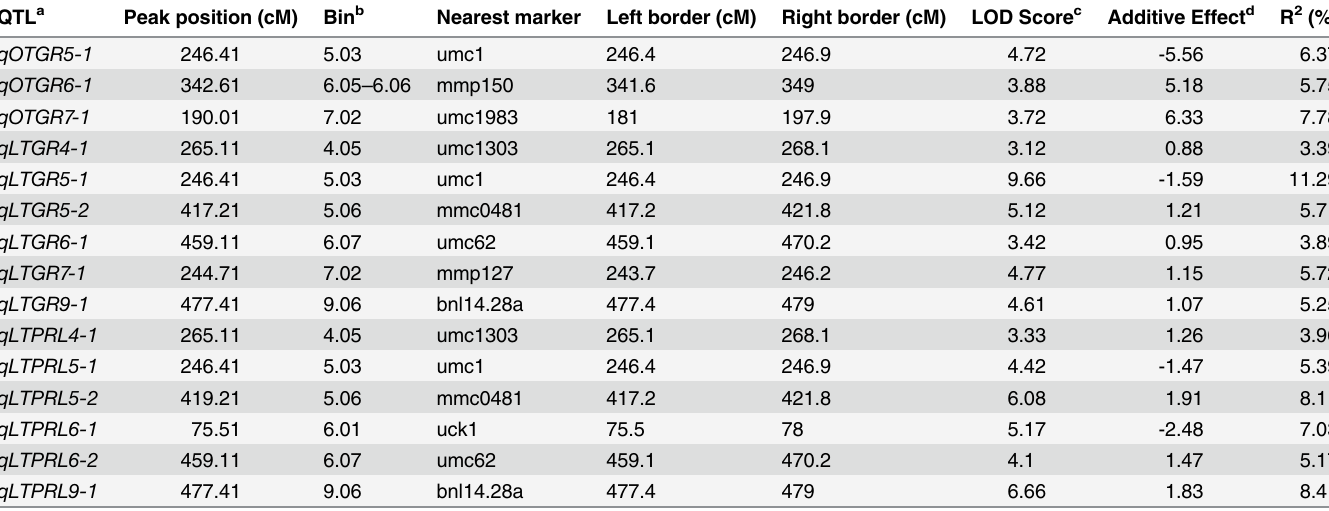
Table 2. QTL detected for controlling germination ability under low and optimum temperature in the IBM Syn4